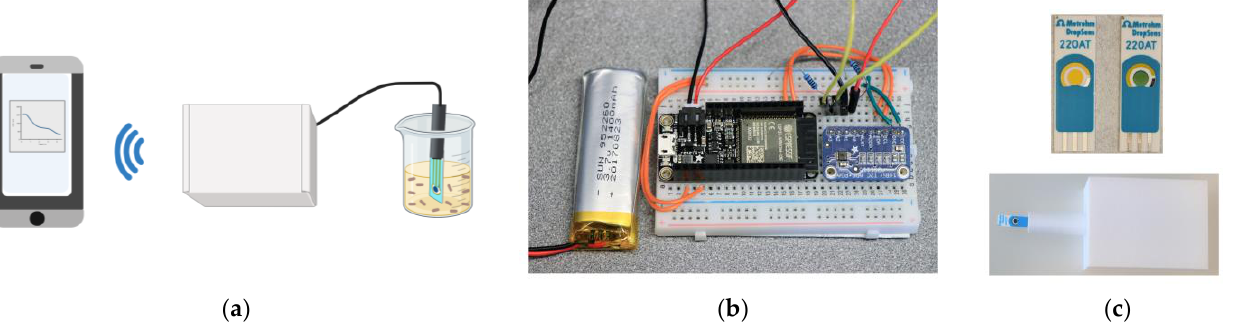
Figure 2 . ( a ) Schematic representation of the wireless-enabled sensing principle, where the E. coli dependent potential of a PrBl-modified SPE is continuously measured by the Arduino, and the data sent to a suitable device (created with BioRender.com); ( b ) Photo of the wireless Arduino microcontroller; ( c ) Photographs of PrBl-modified SPEs in reduced (right) and oxidized (left) form together with an assembled wireless sensing platform, where the Arduino microcontroller is encased in a 3D-printed box and connected to an SPE for insertion in the test medium.